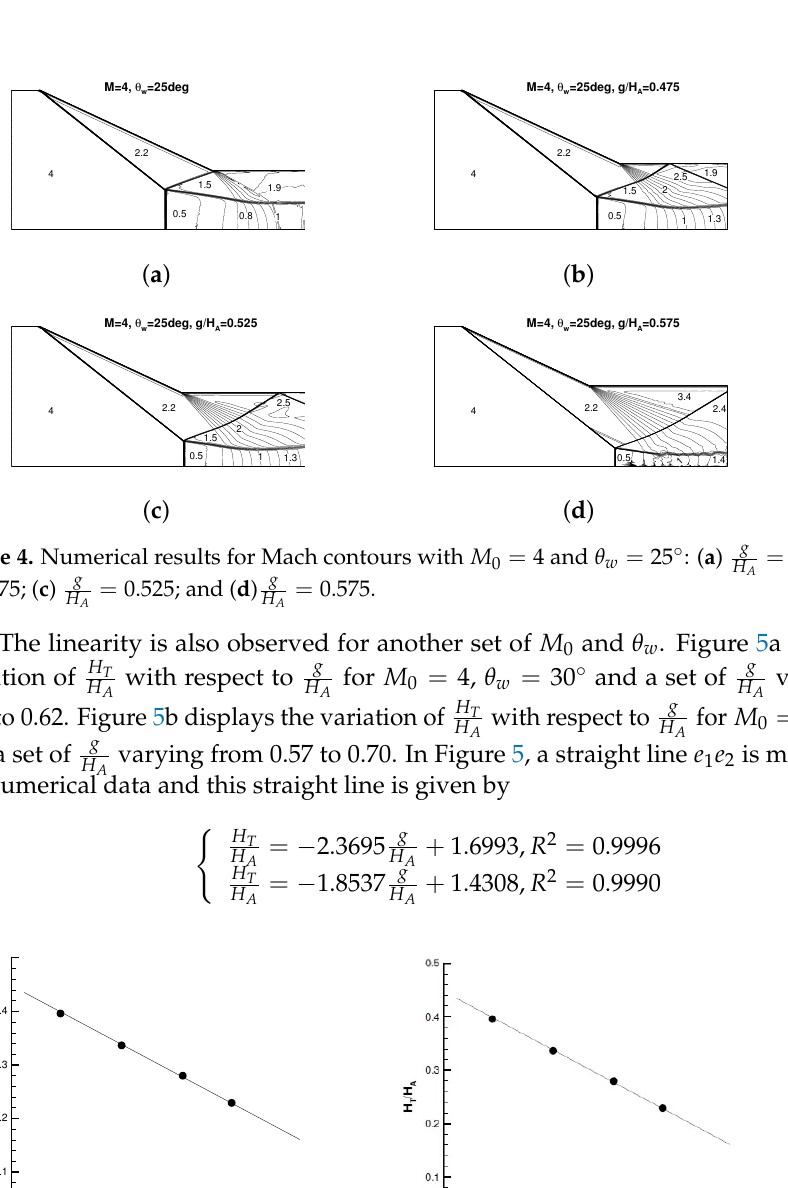
versus g for M 0 = 3 and H A H A